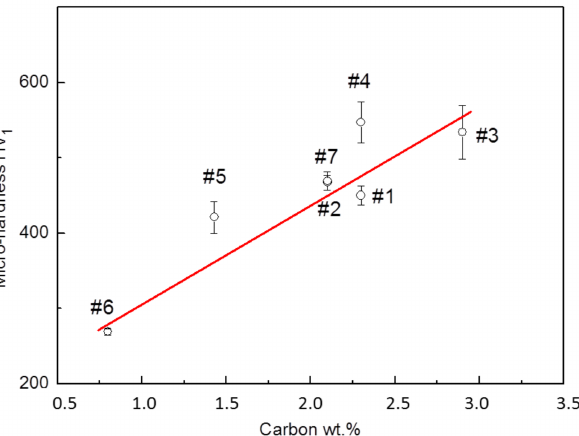
Figure 8. Micro-hardness vs. C content determined in different samples through XRD. Micro-hardness values were obtained by applying a load of 1000 g.